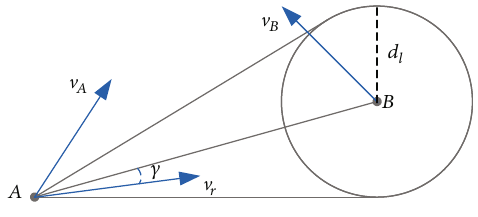
Figure 2: Velocity obstacle model.